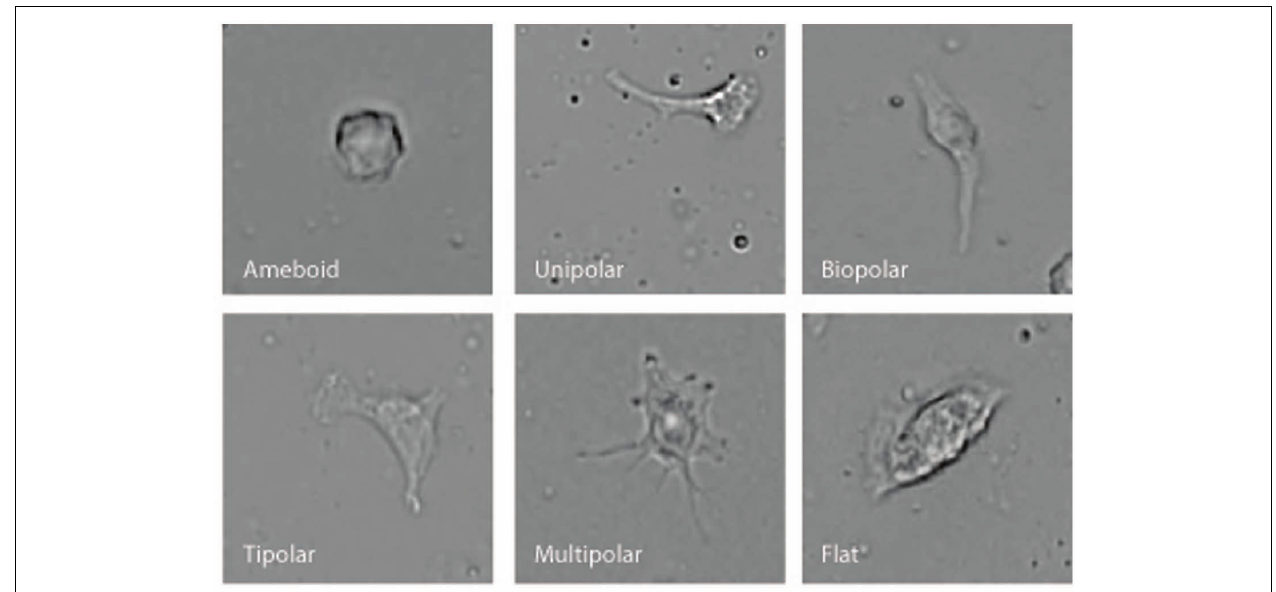
FIGURE 1 | Examples of the six different BV-2 morphological shapes observed and categorized.